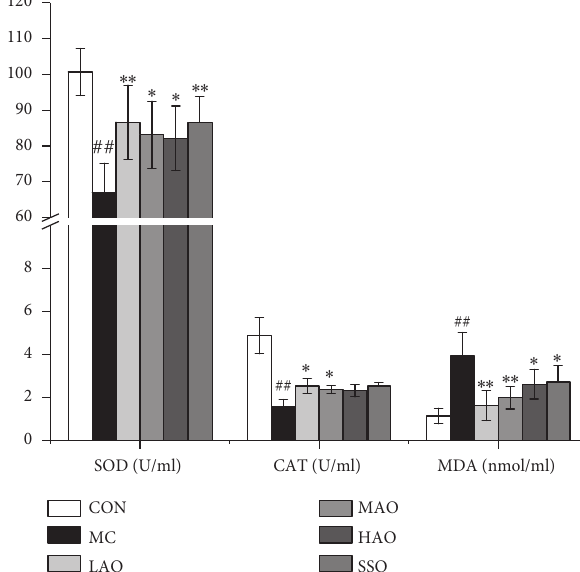
Figure 3: Effect of almond oil on serum oxidative status in STZ- induced rats. SOD, superoxide dismutase; CAT, catalase; MDA, malondialdehyde. Data were expressed as means ± SD. The MC group was compared with the CON group, # P < 0 . 05, ## P < 0 . 01; the LAO, MAO, HAO, and SSO groups were compared with the MC group, ∗ P < 0 . 05, ∗∗ P < 0 .